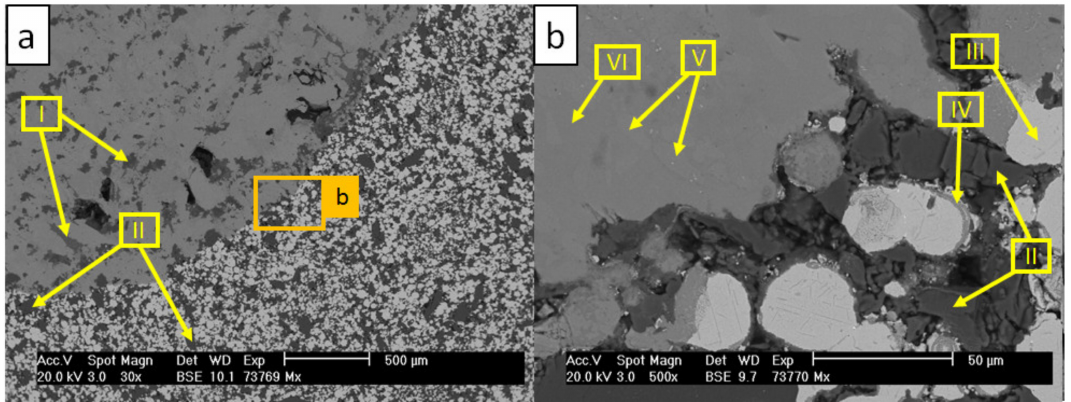
Figure 12. SEM micrographs of the C_850 composite crucible after the corrosion test with molten AlSi7Mg0.3 aluminum alloy at 850 ◦ C: ( a ) image magnified to 30 × ; ( b ) image magnified to 500 ×